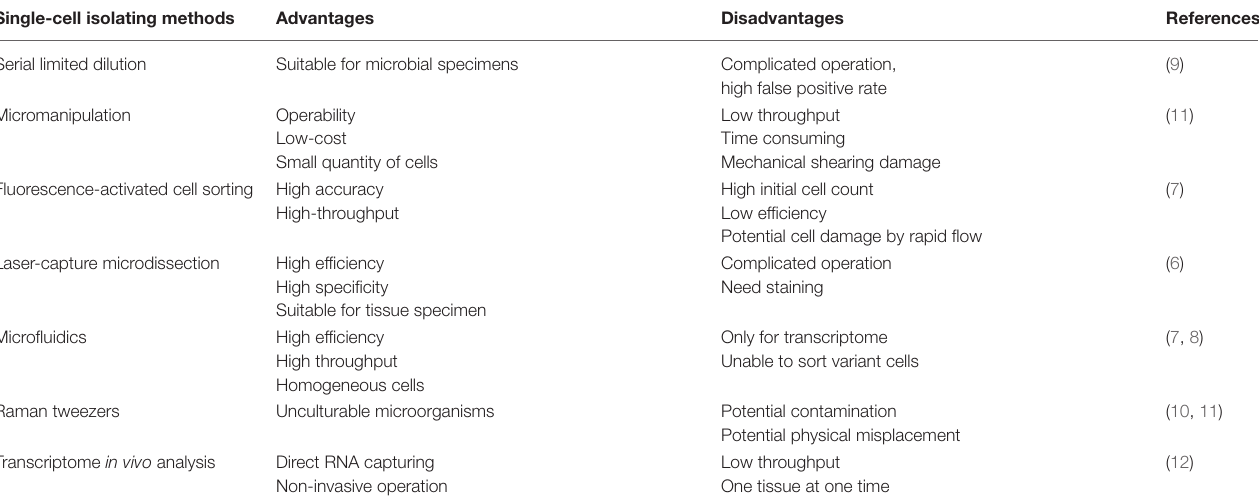
TABLE 1 | The currently used single-cell isolating methods with respective advantages and